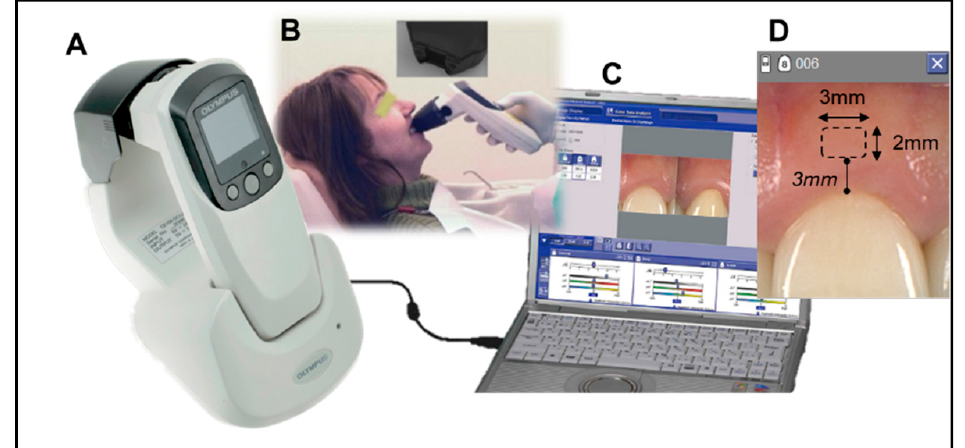
Figure 1. Spectrophotometric color measurement of the gingiva. ( A ): Spectrophotometer Crystaleye ® . ( B ): Measurement is taken using a special rubber-cap for non-contact measurement. ( C ): The spec- trophotometric data is transferred to the Crystaleye ® software for color data analysis. ( D ): The color reading of the rectangular area (3 mm × 2 mm) 1 mm above the tooth was obtained.